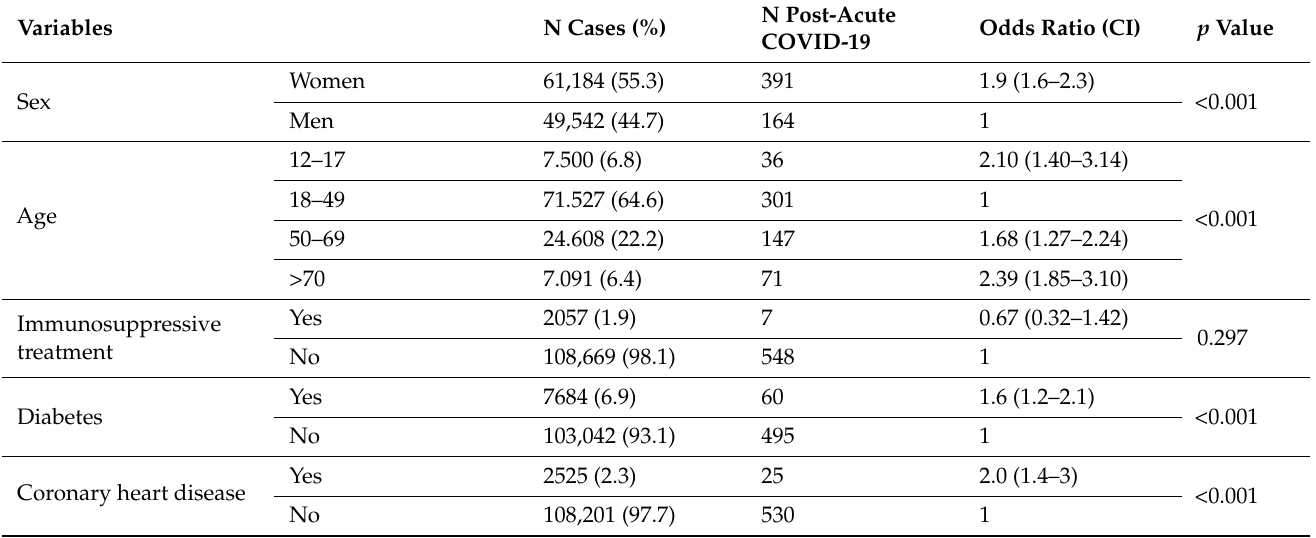
Table 1. Association between predictor variables and post-acute COVID-19 in 110,726